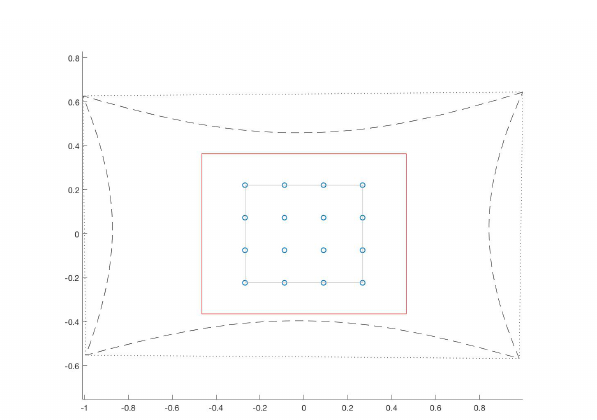
Figure 10 . parallax error in the scene image for fixation dis- tance at 3 m when d cal = 1 m on the setup described in Ta- ble2. This figure assumes an ideal mapping function with zero interpolation and extrapolation error in the entire image for the calibration distance d cal .